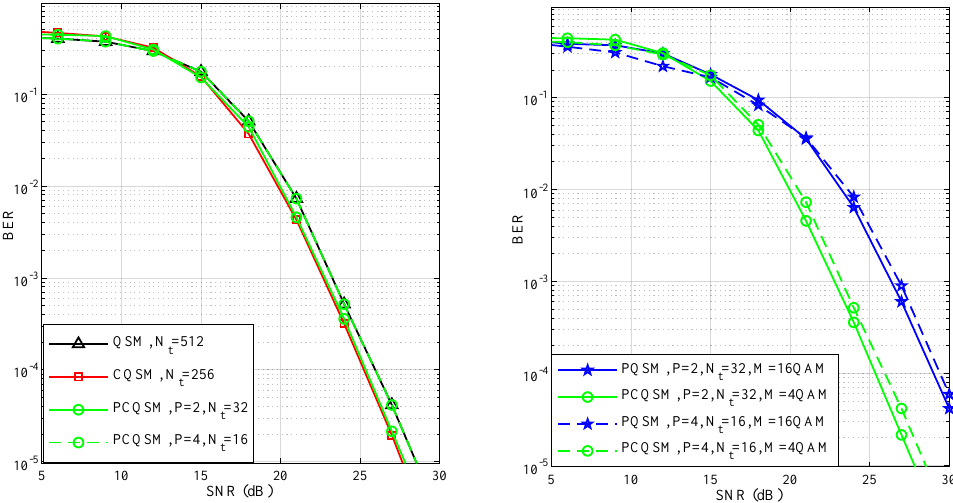
Figure 4. Performance comparison of ( a ) SM schemes with transmission rate of 20 bits/s/Hz with same number of receive antenna, N r = 4 and modulation order M = 4-QAM. ( b ) PQSM and PCQSM schemes with 2 and 4 groups to achieve a transmission rate of 20 bits/s/Hz, N r =